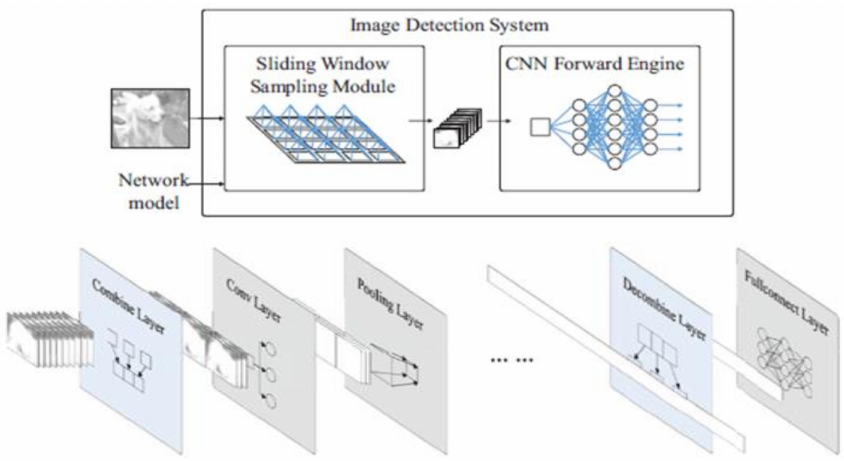
Figure 5. GPU-based approach for image target detection [31]. (Reprinted with permission from ref. [31]. Copyright 2021 IEEE).